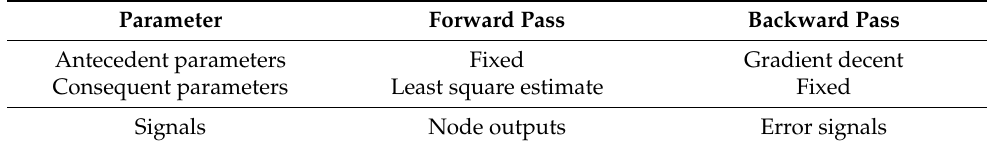
Table 3. Two-pass parameter identification of the GD-LSE